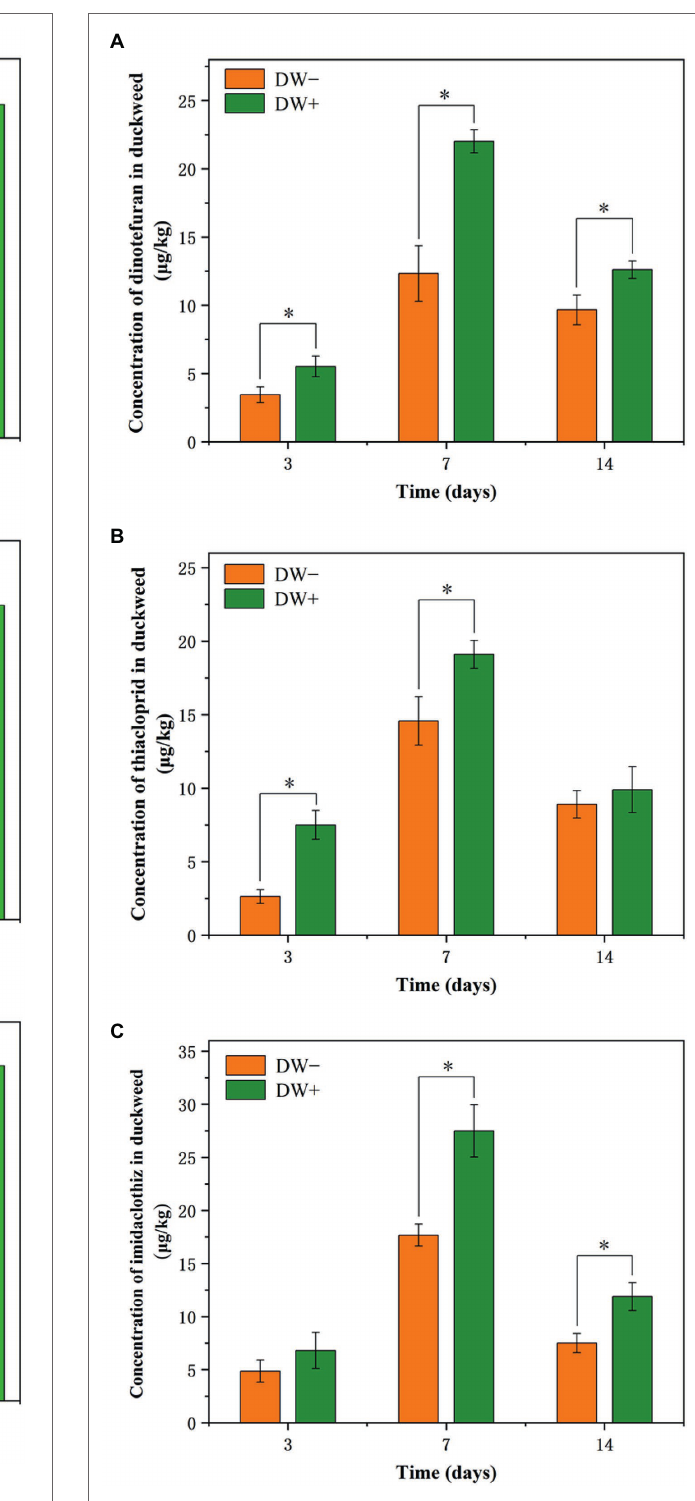
FIGURE 6 | Concentrations of dinotefuran (A) , thiacloprid (B) , and imidaclothiz (C) in the inoculated and uninoculated duckweed plants. Treatments: DW − , uninoculated duckweed; DW+, duckweed inoculated with stain FC02. Error bars represent standard deviations ( n = 3). Asterisks indicate a significant difference between treatments on the same day ( p < 0.05, t